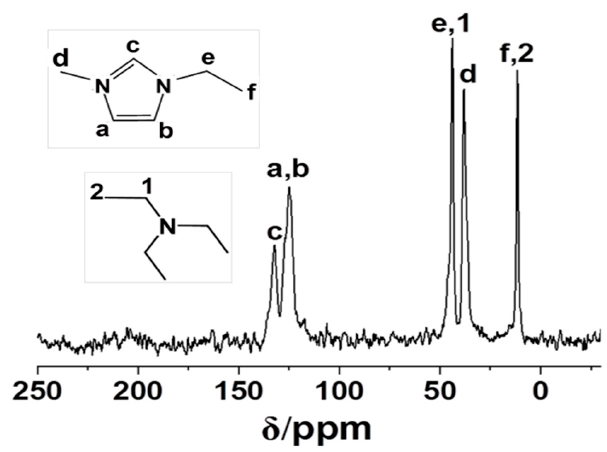
Figure 7. 13 C NMR spectra of sample S-EM-C.